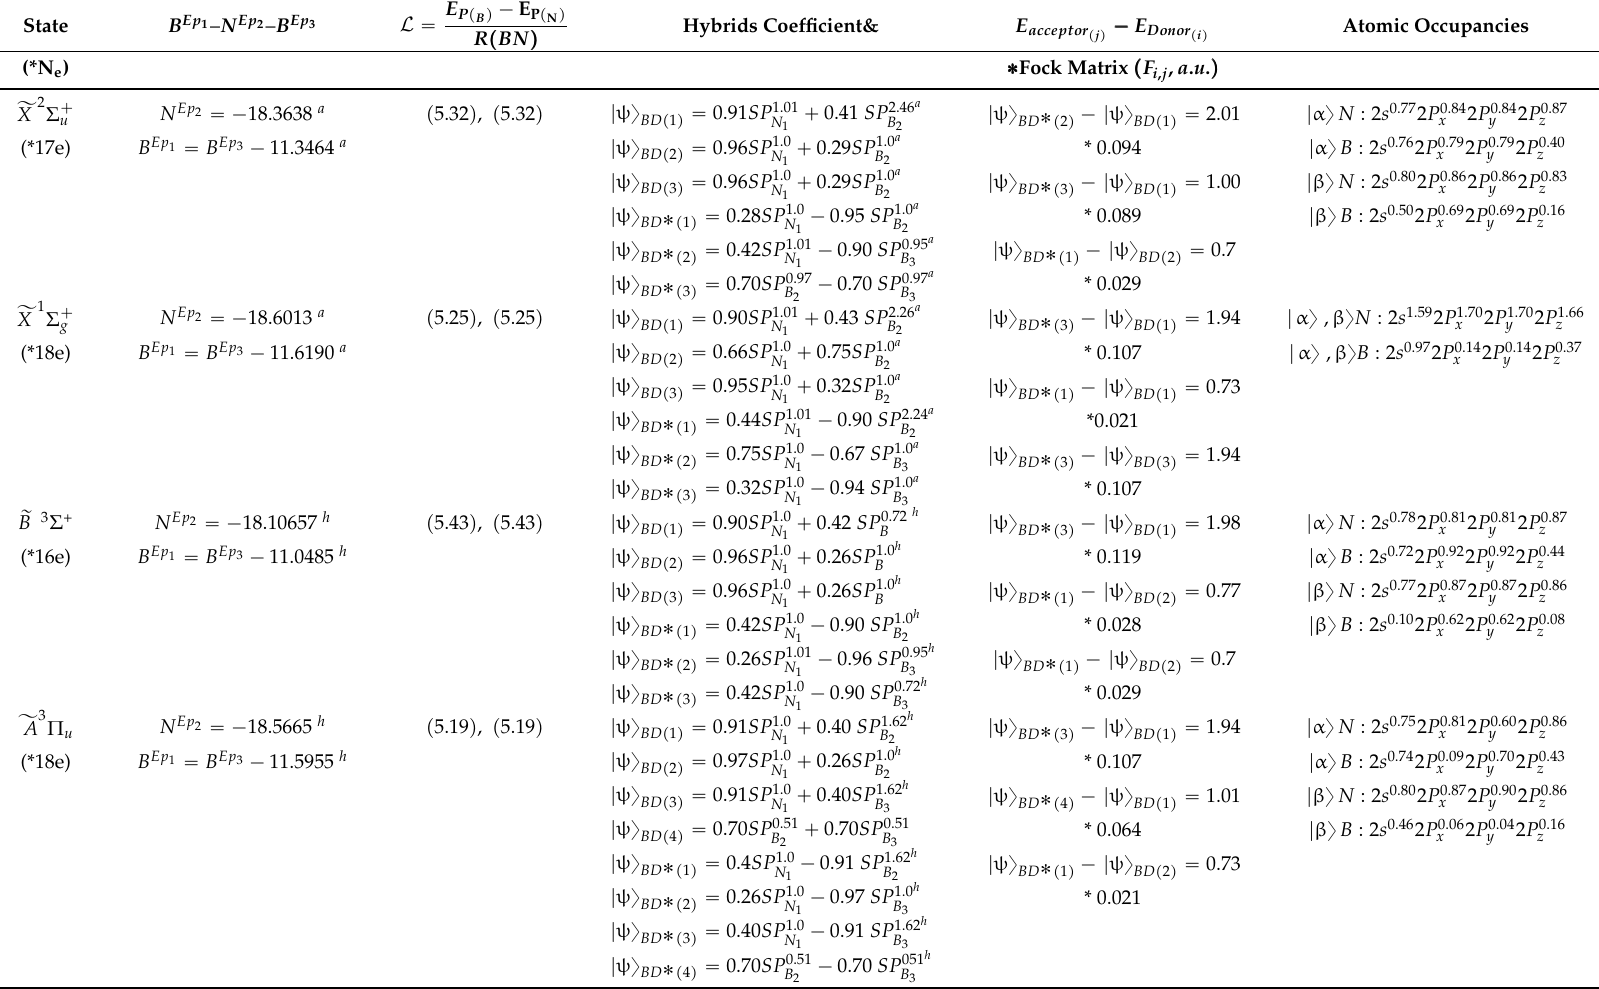
Table 2. NBO, electric potential, gradient of electric potential p L q , atomic occupancies, and Fock Matrix data of B 2 N p´ ,0 , +) in ground and exited